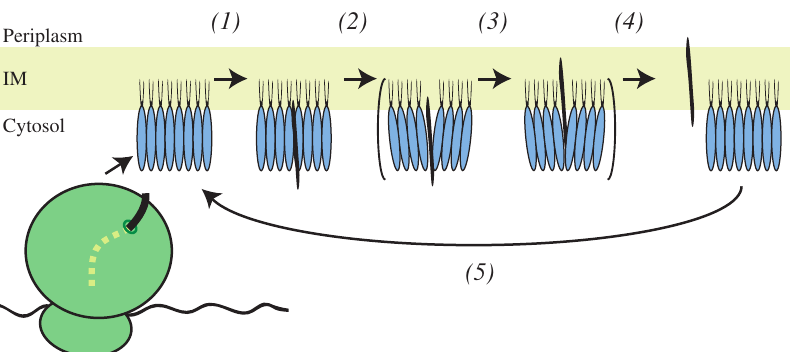
Figure 4 Working model for Sec-independent integration. Newly synthesized membrane proteins are received by the glycan chains of MPIase (1). Possible structural changes of MPIase allow integration into the lipid bilayer (2–4). Upon release of a membrane protein, MPIase is recruited for the next cycle to ensure the catalytic reaction (5).